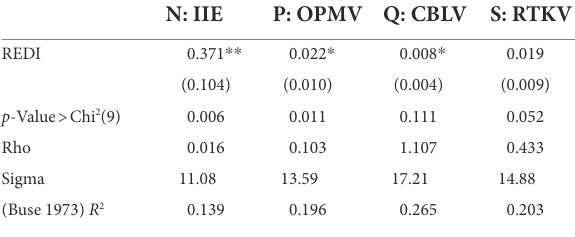
TABLE 8 Control space